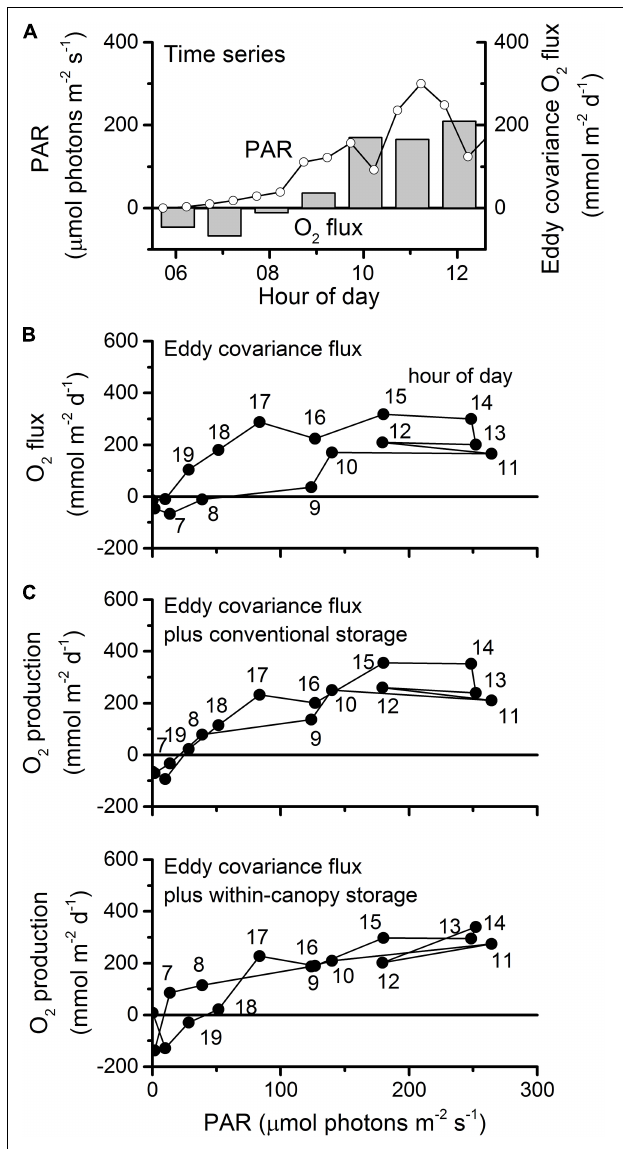
FIGURE 3 | Correction of eddy covariance O 2 flux for the storage of O 2 in the water volume of the open-water canopy. (A) Morning PAR and eddy covariance O 2 flux measured above the canopy. (B) O 2 flux as a function of PAR showing hysteresis due to O 2 storage. (C) O 2 flux plus the conventional correction for storage using O 2 measured above the canopy. (D) O 2 flux plus our correction for O 2 storage using O 2 measured within the